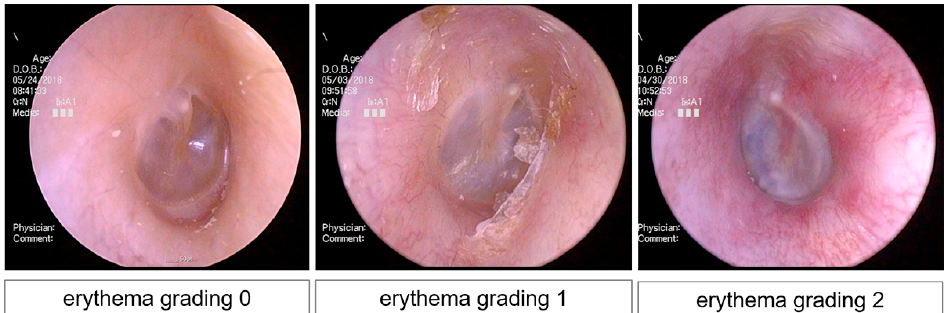
Figure 1. Representative photos used for semi-quantitative scoring of erythema.